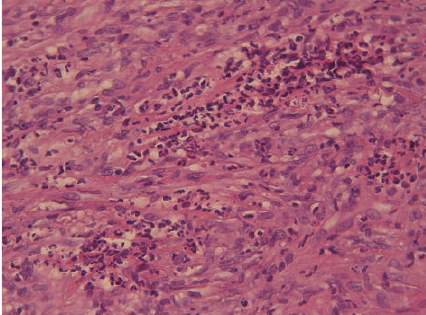
Figure 3: Nasal biopsy showing aggregate mainly consisting of neutrophils within and around blood vessel walls (haematoxylin- eosin